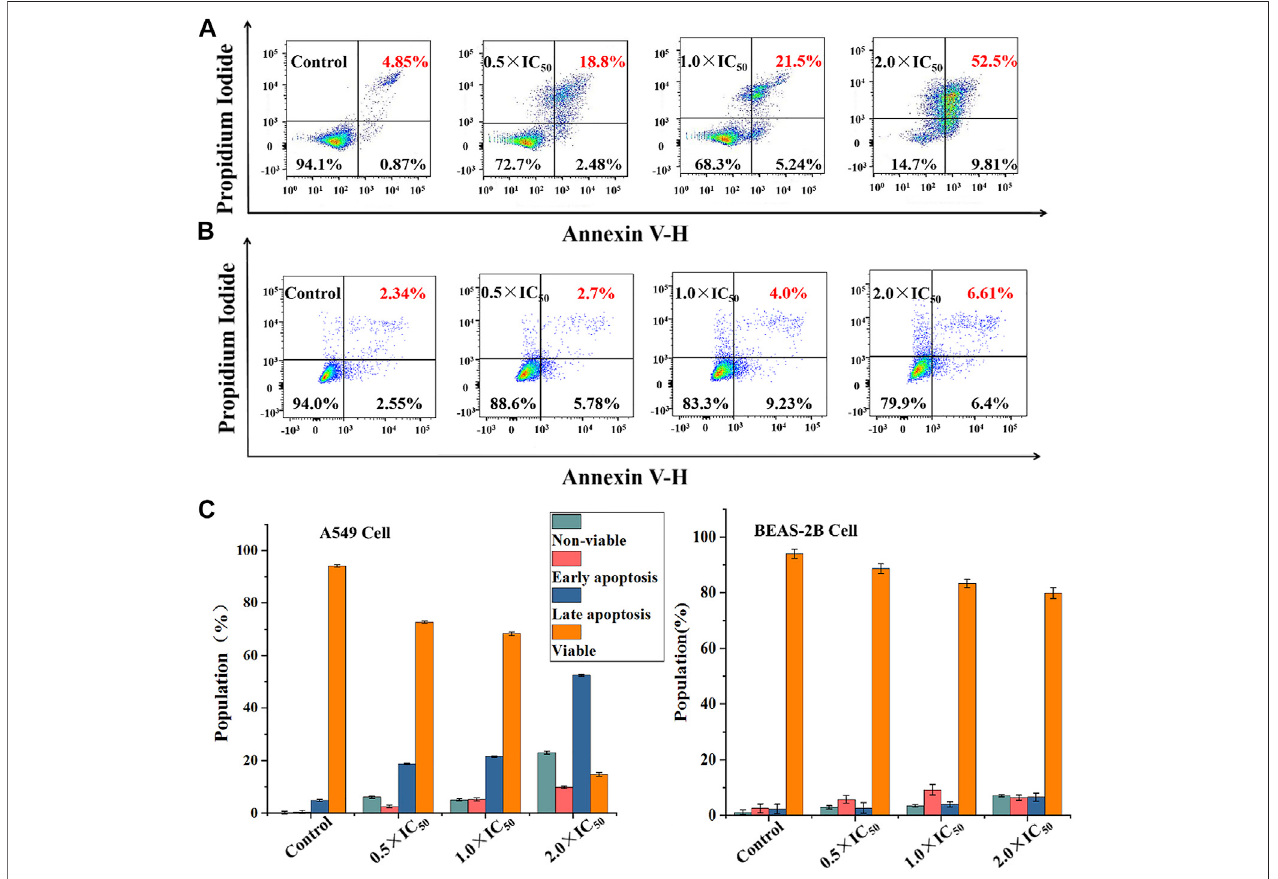
FIGURE 6 | The apoptosis assay was evaluated after A549 cells (A) and BEAS-2B cells (B) hatched with Ir2 for 24 h, and the color dot plots mean that the cells were stained with Annexin V-FITC/PI; (C) The population of viable, apoptotic (early + late) and non-viable cells.